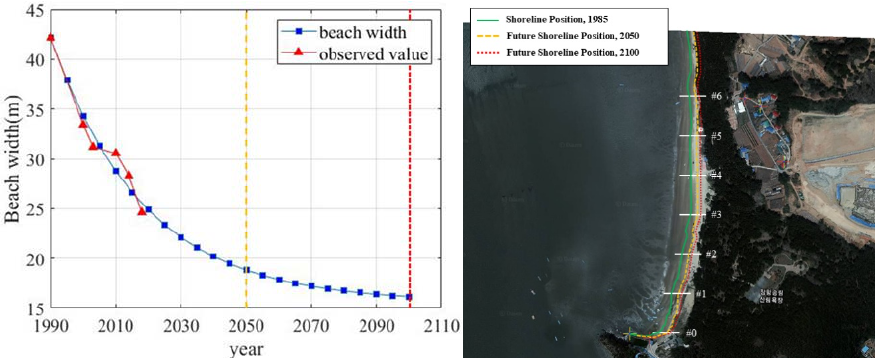
Table 7. Beach width and area of Janghang